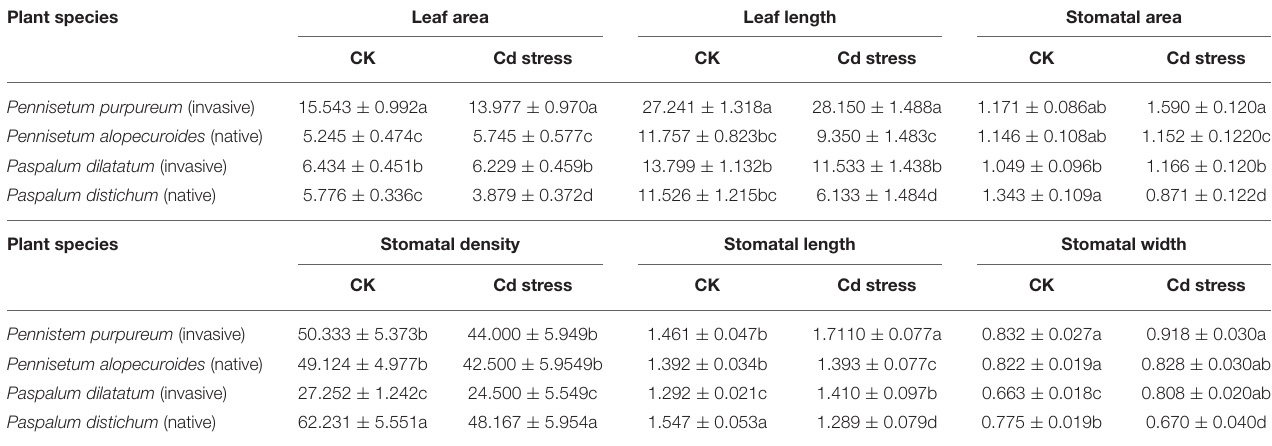
TABLE 2 | The effects of Cd stress on leaf functional traits of each invasive and native plant. Plant